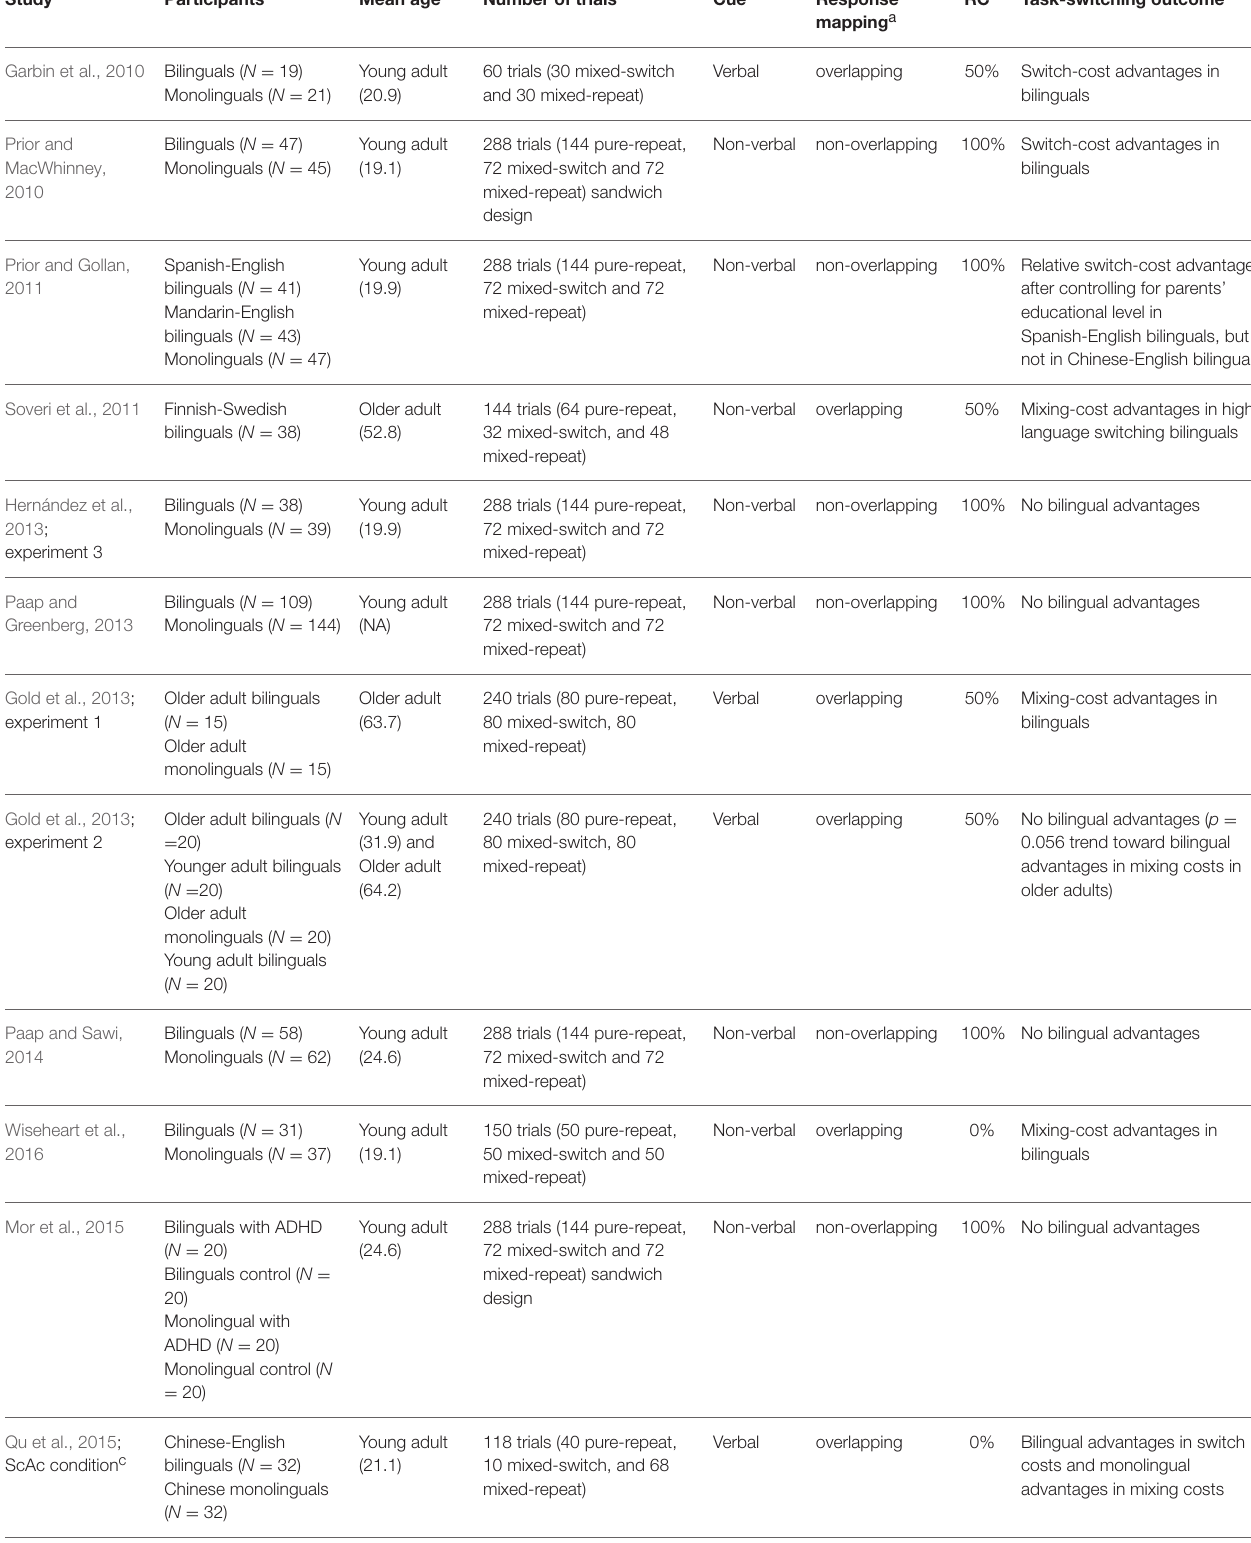
TABLE 1 | Summary of studies examining bilingual benefit using a task-switching paradigm (task-cuing paradigm) in adults. Study Participants Mean age Number of trials Cue Response